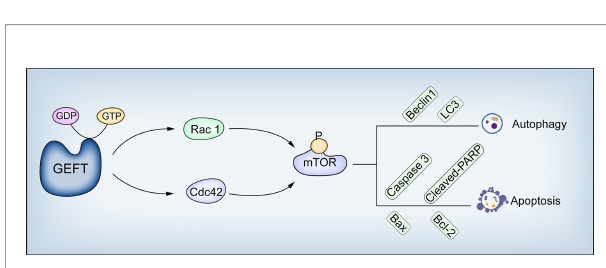
FIGURE 9 | GEFT mechanism diagram in RMS. GEFT inhibits autophagy and apoptosis through the Rac1/Cdc42 – mTOR